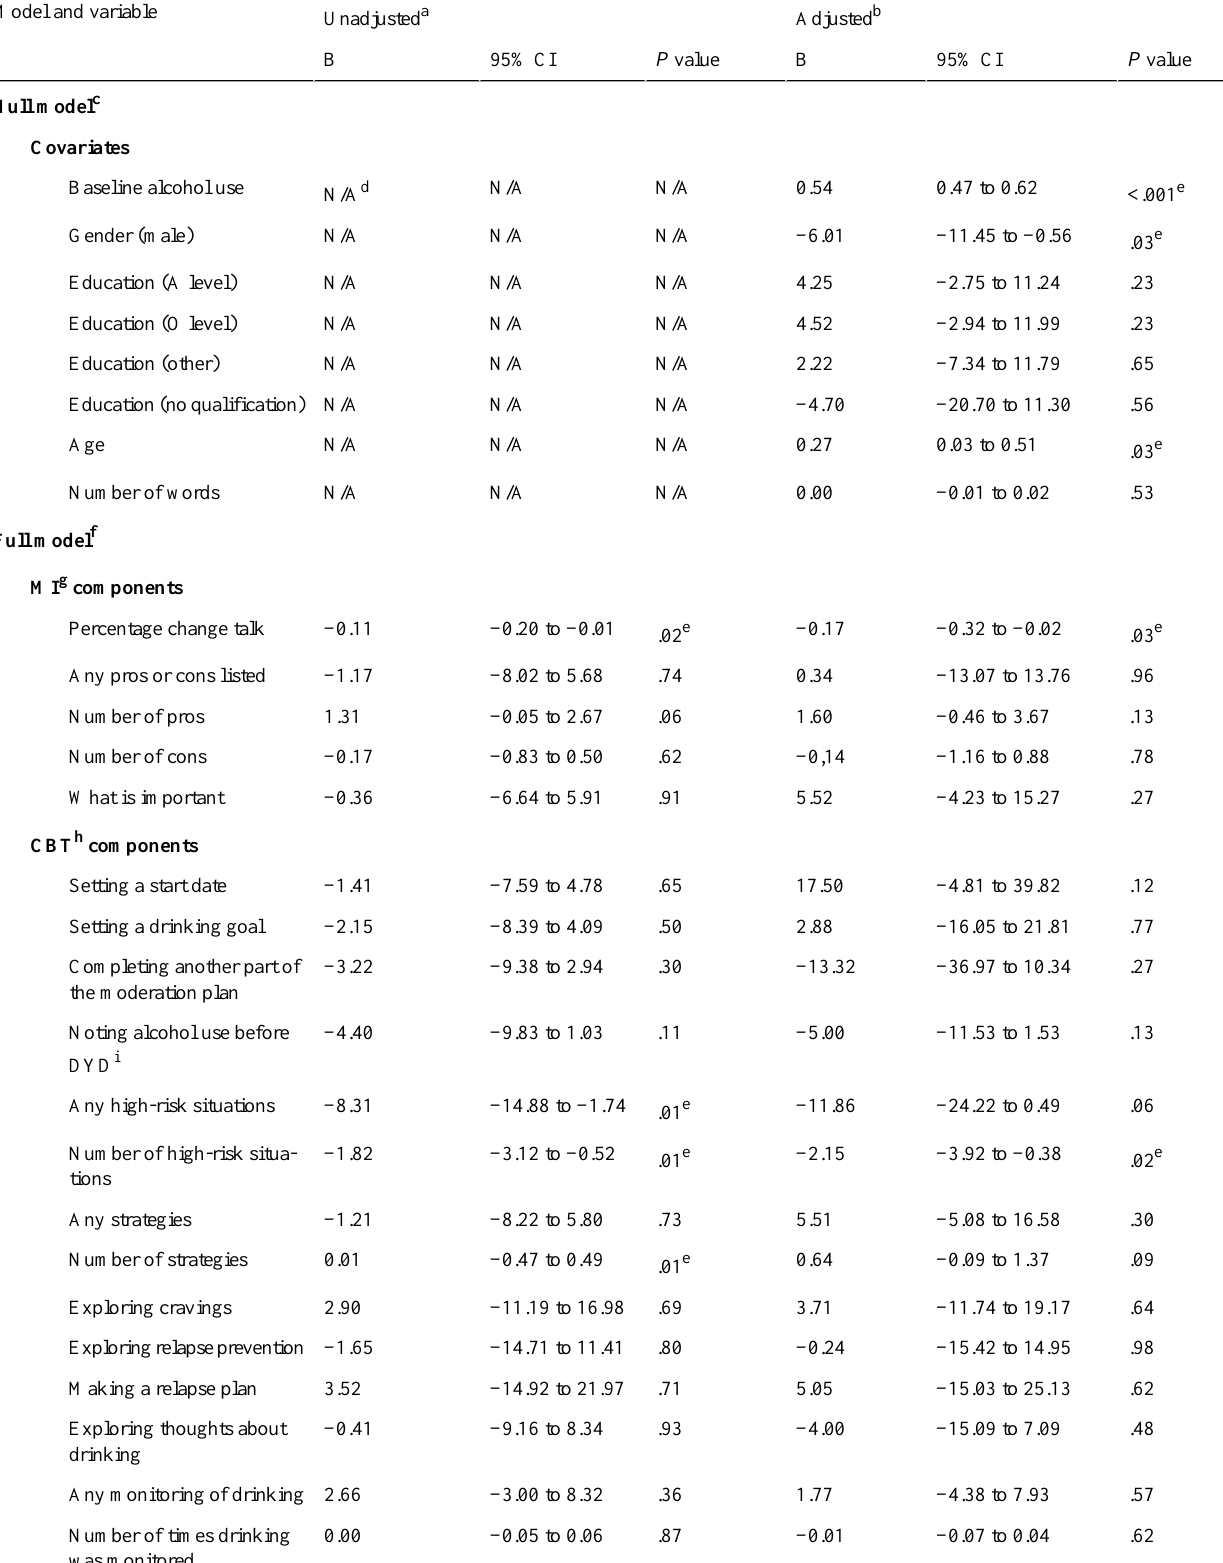
Table 3. Linear model estimates for the subsample of active users